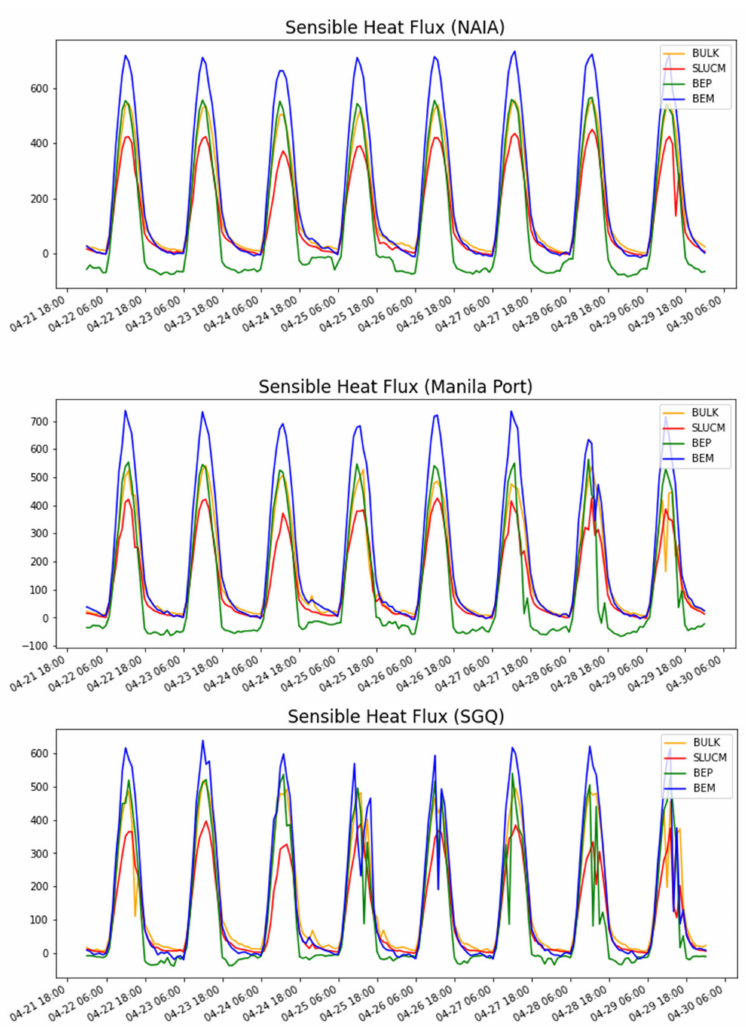
Figure A1. Temporal evolution of the Sensible Heat Flux (W/m 2 ) from 22–30 April